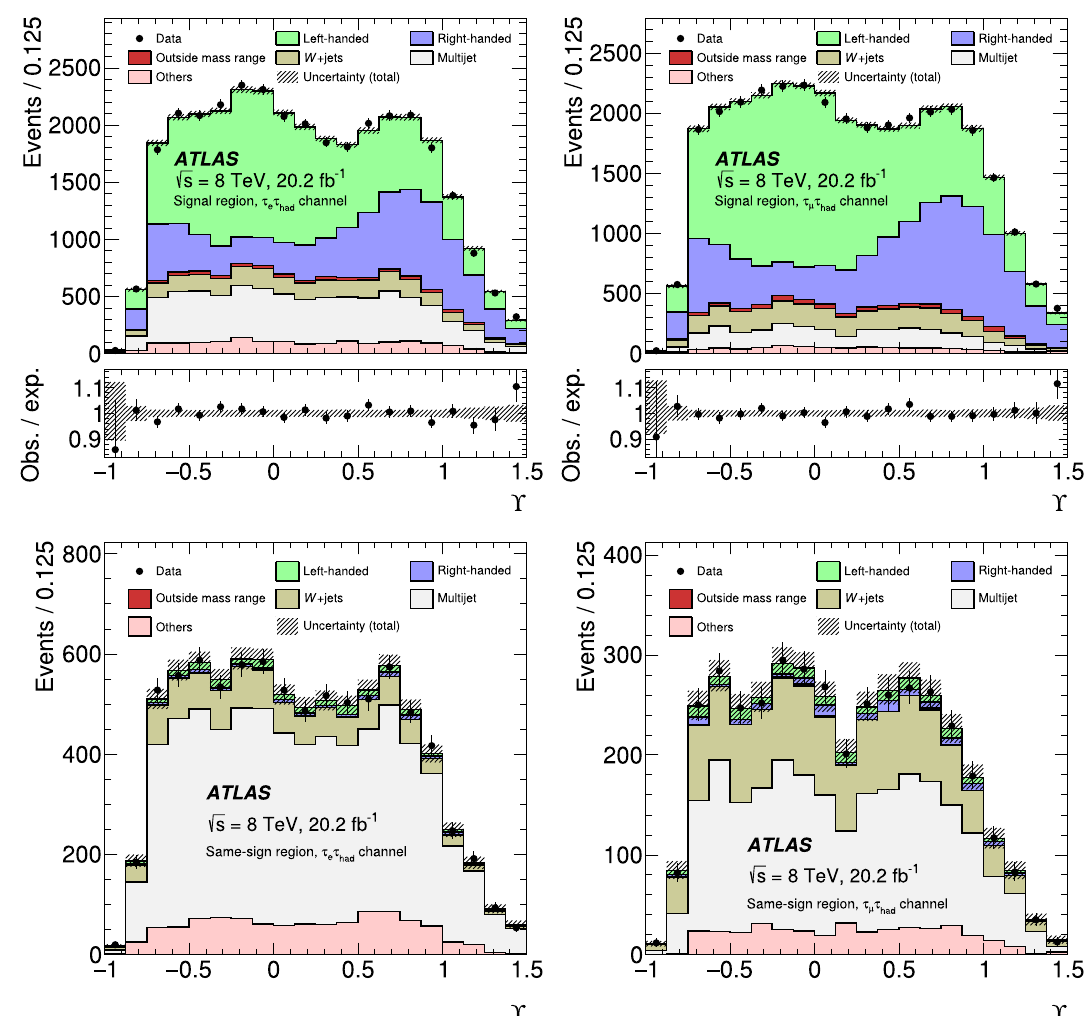
Fig. 5 Post-fit ϒ distributions for the τ e – τ had (left) and τ μ – τ had (right) channels, and for the signal (top) and same-sign (bottom) regions for the fit that extracts the τ polarisation in the mass-selected region of 66 < m Z /γ ∗ < 116